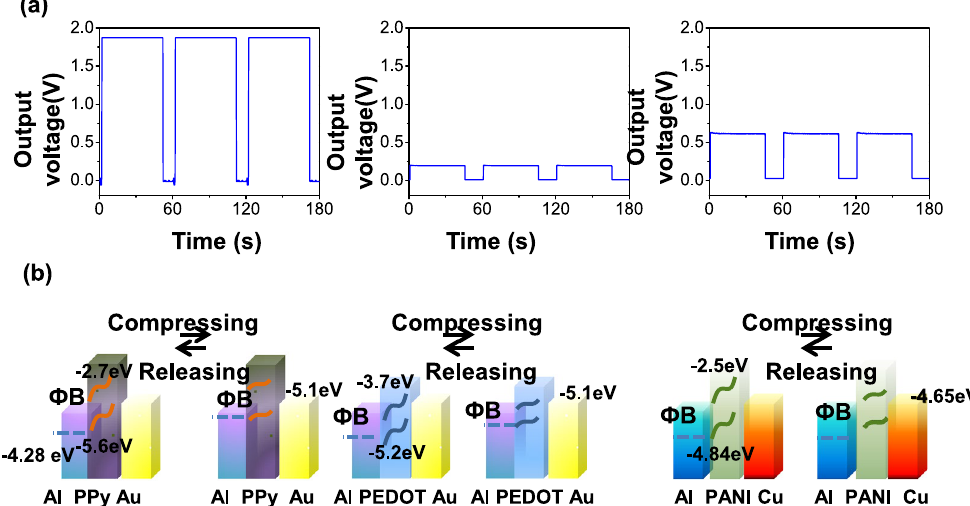
Figure 2. ( a ) Output voltage of direct-current generators measured by oscilloscopes, left panel: Al/PPy/Au, middle panel: Al/PEDOT/Au, right panel: Al/PANI/Cu. ( b ) Proposed energy band diagram of the direct-current generators at freestanding state and at compressing state, left panel: Al/PPy/Au, middle panel: Al/PEDOT/Au, right panel: